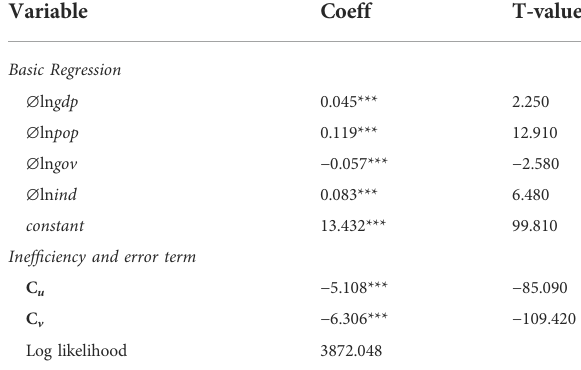
TABLE A1 Results of energy demand stochastic frontier